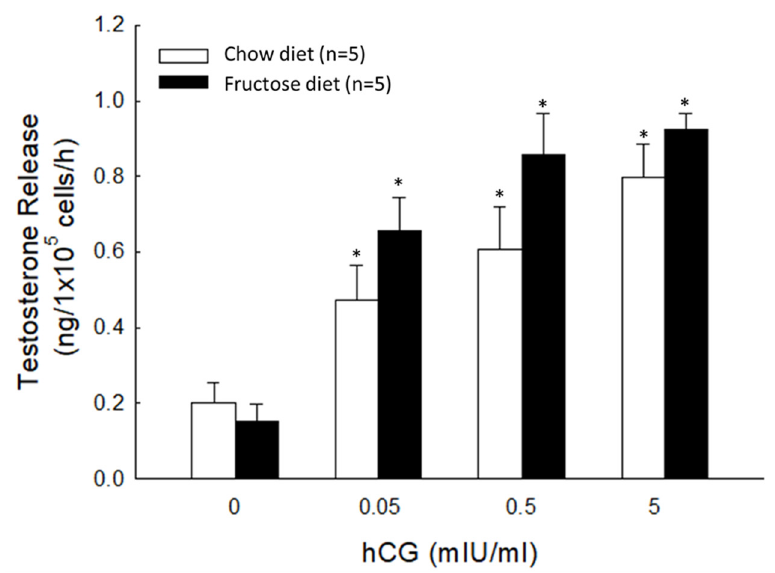
Figure 4. Testosterone release in response to different concentrations of hCG. Basal and evoked testosterone release in response to different concentrations of hCG in rat Leydig cells purified from the fructose-diet fed group (black column) and the control group (white column). * p < 0.05 as compared to the vehicle group (dosage:0). Each value presents mean ± SEM. Similar results were repeated twice.